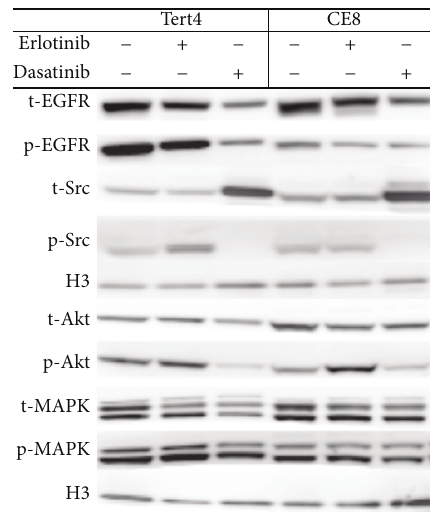
Figure 5: Western blot analysis of total and activation of the EGFR, Src, Akt, and MAPK in hMSC-TERT4 and hMSC-TERT20-CE8 which is clonal cell line derived from mesenchymal (stromal) stem cells and with the ability to form sarcoma-like tumours in mice. The cell lines were treated for 72 h with either vehicle, erlotinib 5 𝜇 M, or dasatinib 5 𝜇 M. t, total; p, phosphorylated. Histone H3 was used as loading control. For quantification data, see supplementary Figure